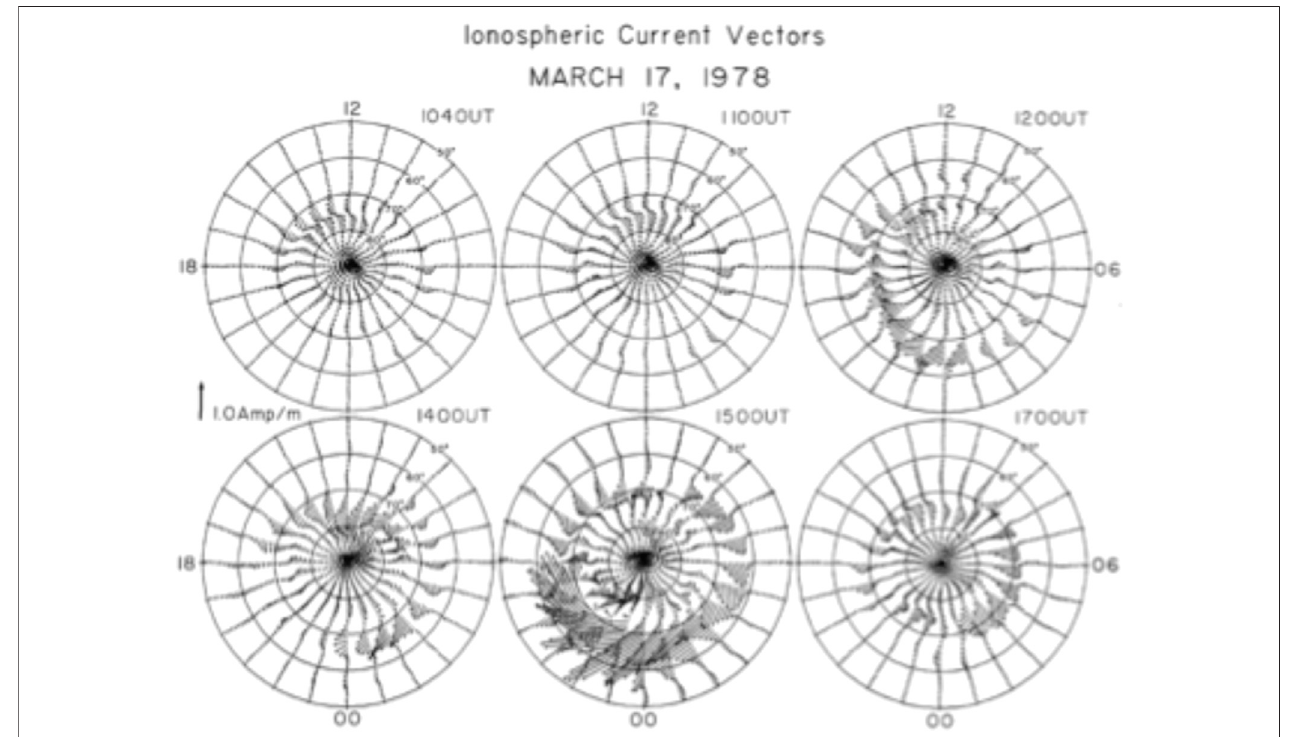
FIGURE 13 | An example of the growth and decay of electric currents during the expansion phase of auroral